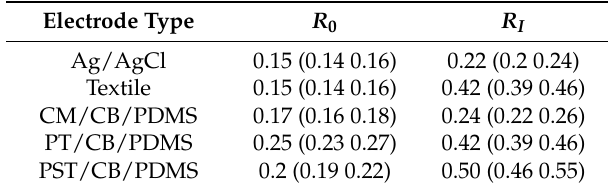
Table 2. Coefficient of variation (unitless) for the different electrodes.